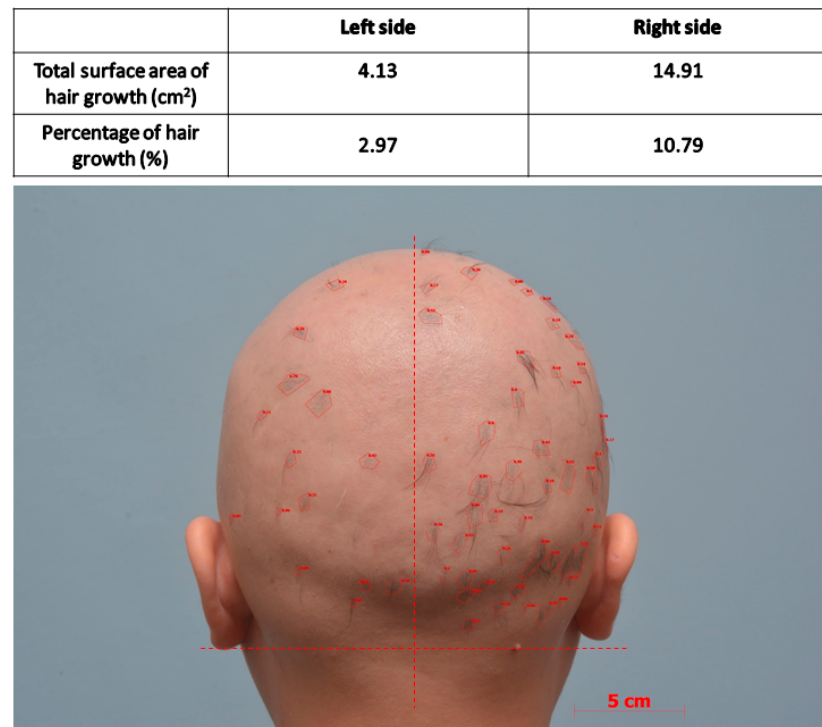
Figure 4. Total surface area and the percentage of hair growth on each side of the scalp after laser treatment. (Percentage of hair growth % = total surface area of hair growth on one side of the scalp/total surface area of the same side of scalp.)